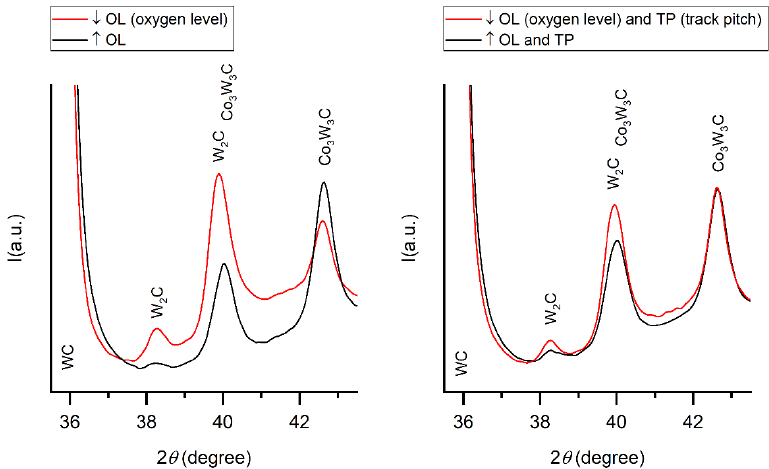
Figure 3. XRD pattern obtained from the produced WC-CoCr coatings using different spray parameter settings.